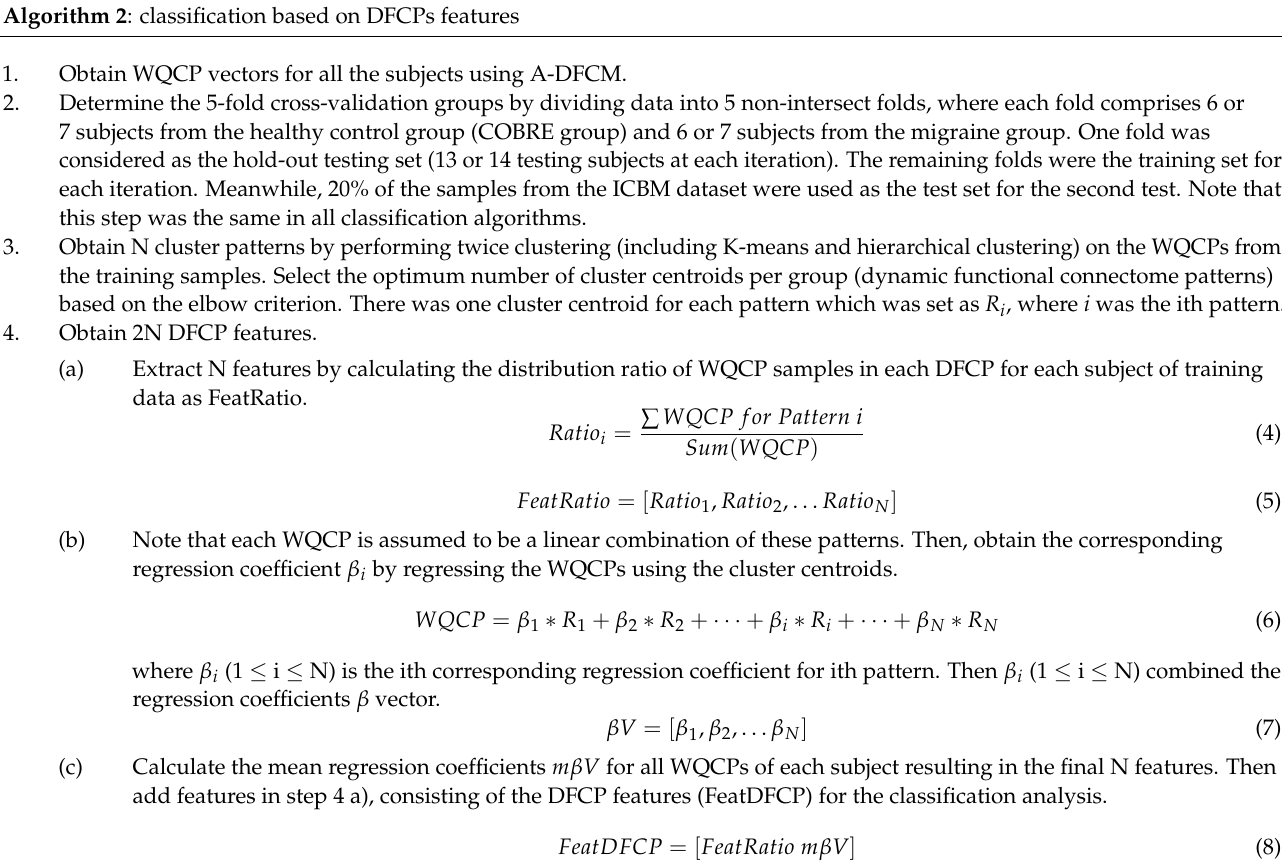
Algorithm 2 : classification based on DFCPs